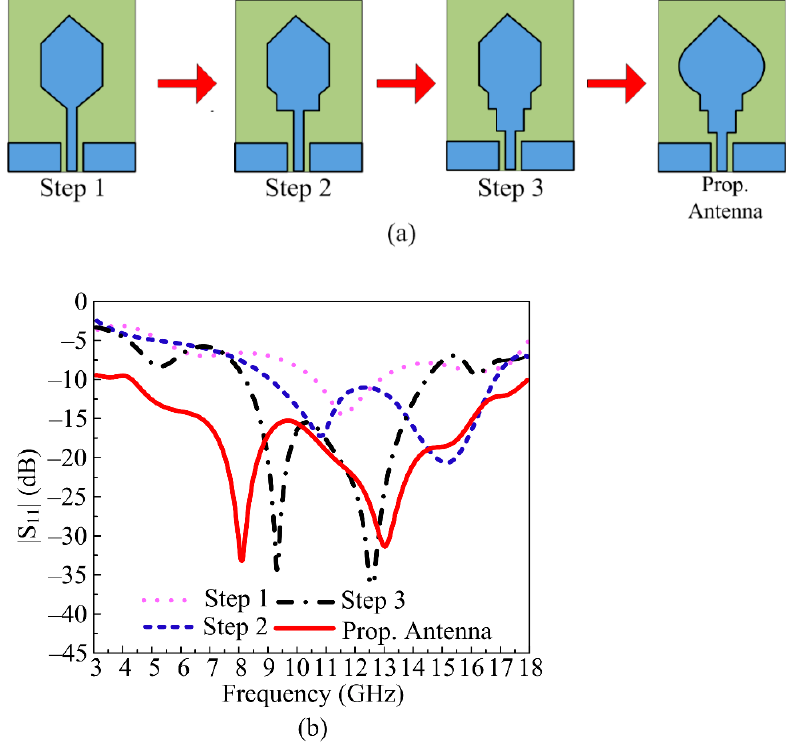
Figure 2. ( a ) Various design steps of proposed UWB antenna: ( b ) effect of design stages on |S 11 | parameter.